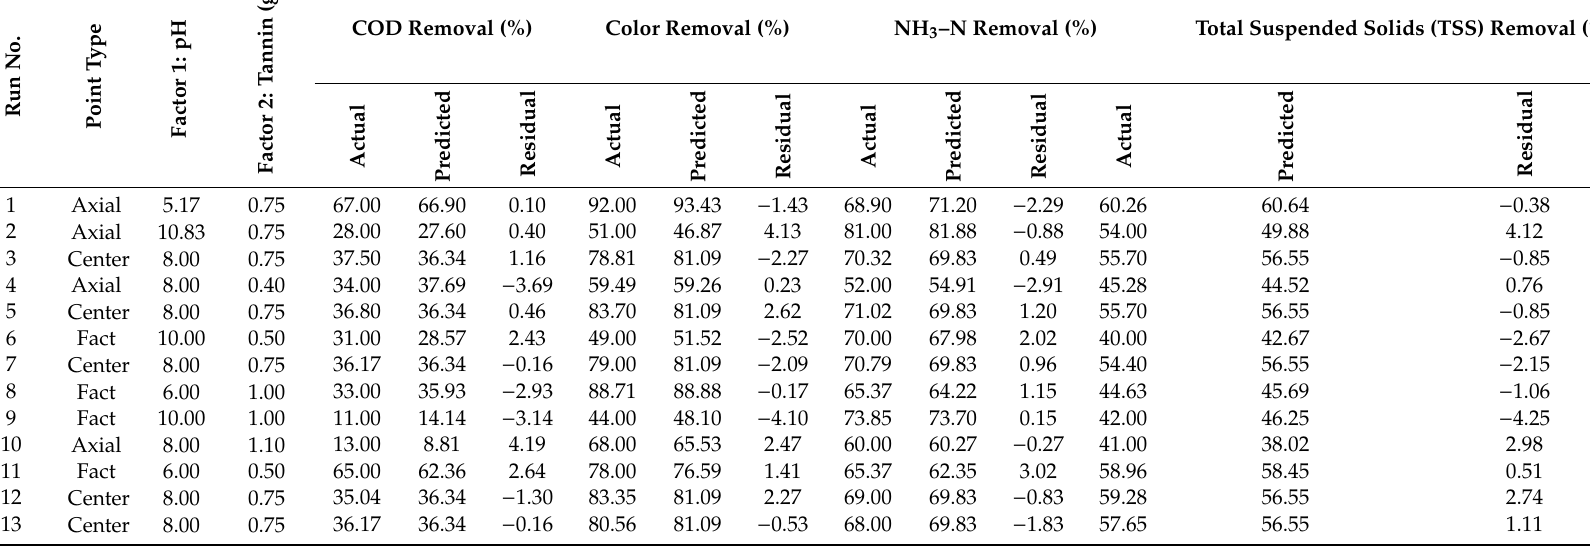
Table 3. Experimental design conditions and actual and predicted removals for the parameters for leachate coagulation with